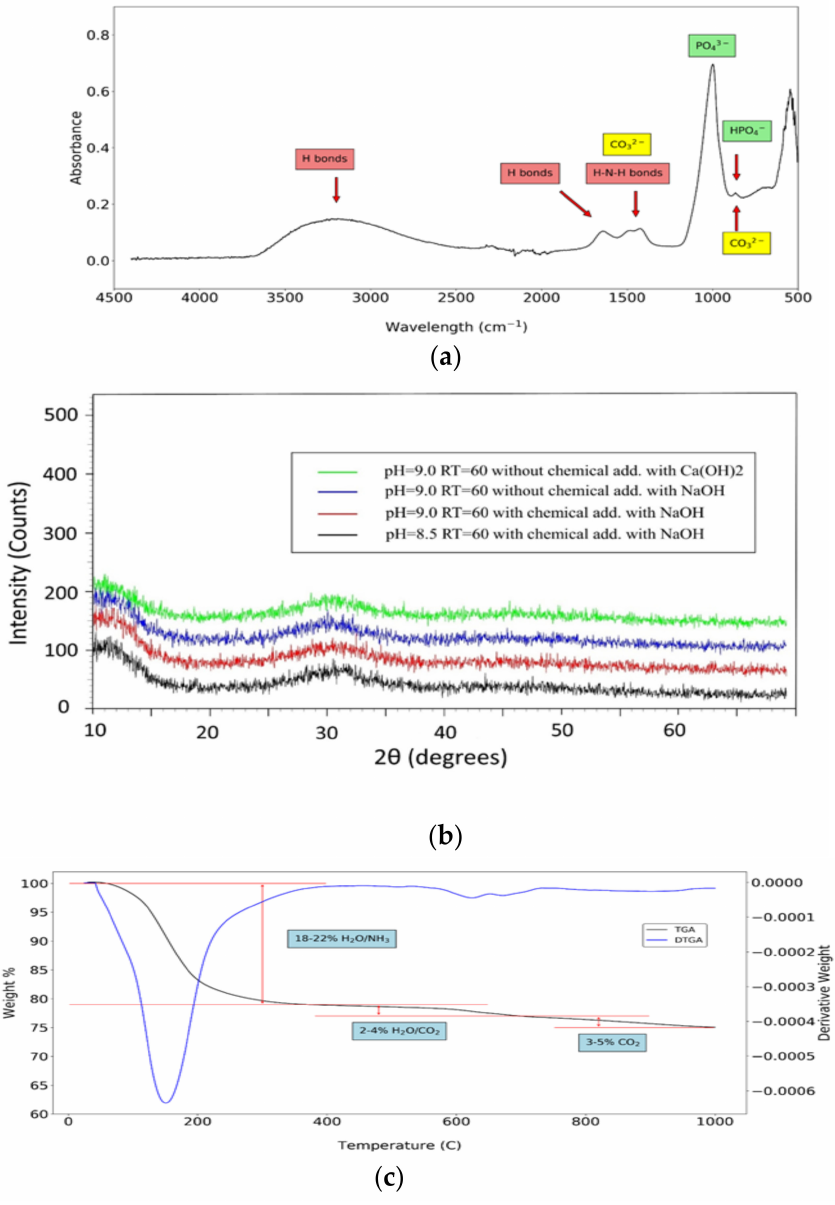
Figure 7. ( a ) FTIR (top). ( b ) XRD (center) and ( c ) TGA (bottom) analyses of precipitate